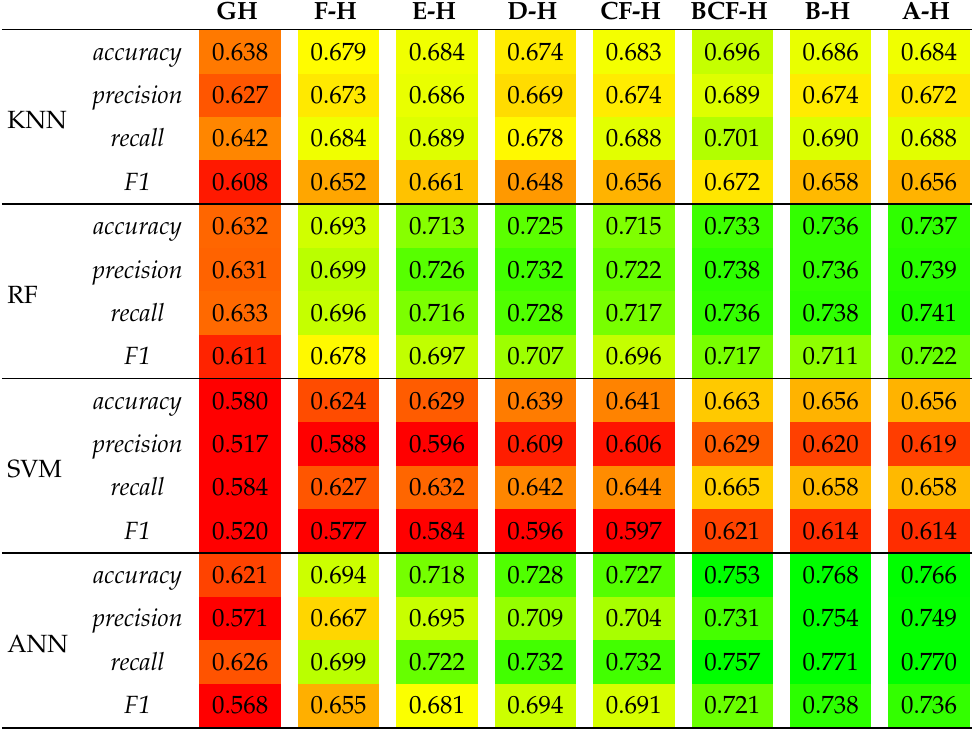
Table 2. Values of the selected metrics obtained for the analyzed models.